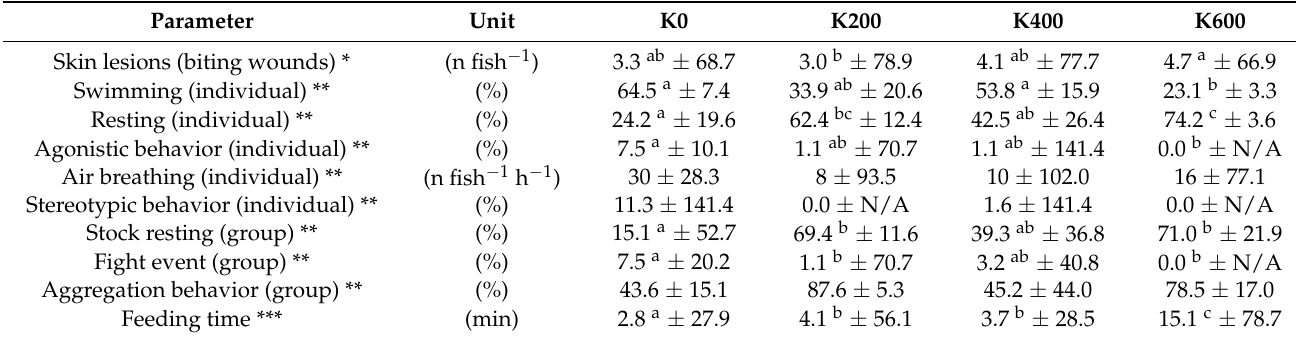
Table 3. Welfare indicators of C. gariepinus challenged with different amounts of dissolved potassium (*: n = 48 ( − mortalities); **: n = 6; ***: n = 51; means ± CV).